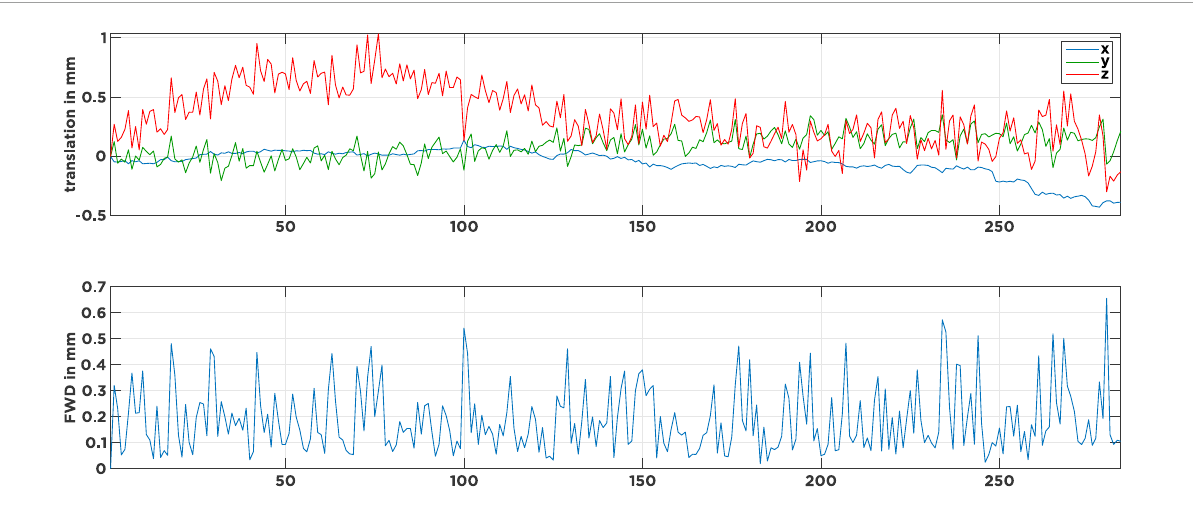
FIGURE1 Motion parameters of a typical subject with continuous tremor-like high-frequency motion. The top panel describes the head movement induced translations in 3-dimensional space over time. The bottom panel shows the corresponding frame-wise displacements (FWD) as an estimate of motion magnitude from one volume to the next. Visible are the many FWD spikes that surpass the 0.2 mm threshold and only a few at the 0.5 mm